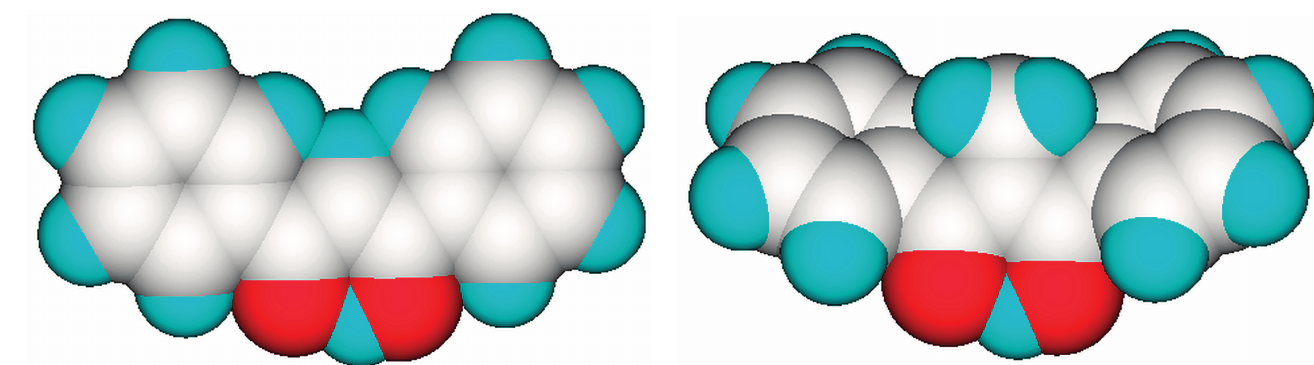
Figure 4. Energy-minimized enol forms of dibenzoylmethane ( left ) and of 1,1-bis(benzoyl)ethane showing the steric effect of the additional methyl group on the structure of the latter (graphics by ChemBrain